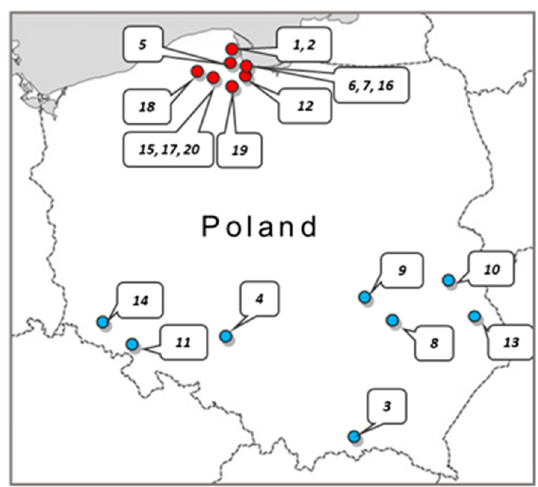
Figure 4. Map of Poland indicating the geographic origin of the propolis samples. The dots ( ● — Pomerania Province; ● —middle/southern region of Poland) indicate the place where the propolis samples were collected. 1 , 2 —Rumia, 2015; 3 —Kamianna, 2015; 4 —Kluczbork, 2015; 5 —Czeczewo,